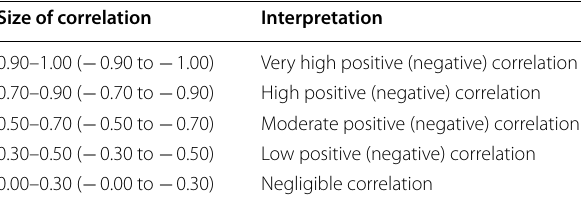
Table 2 Cut-off values for interpretation of coefficient correlation Size of correlation